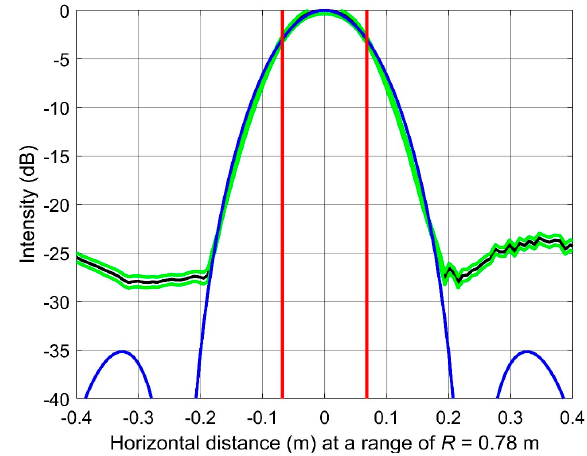
Figure4. Themeasuredbeampattern(solidblackline)and ± onestandarddeviation(green). Alsoshown is the Airy di ff raction pattern at 24 kHz (blue line) and the half-power range limits (red